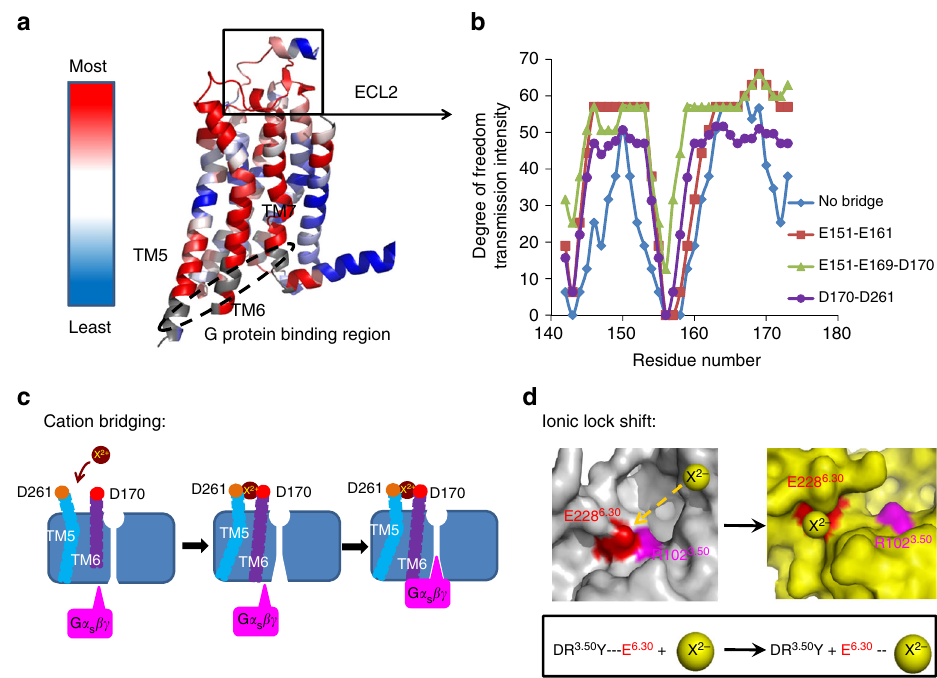
Fig. 7 Proposed mechanism of allosteric activation of A 2A R by divalent cations. a Using the RTA analysis, regions are colored based on the intensity of degrees of freedom (DOF) transmitted to the G-protein-binding region (depicted in a dashed ellipse) with red regions having highest transmission. b Comparison of intensity of transmission of degrees of freedom to the G-protein-binding site as a result of perturbing rigidity through rigidi fi cation of sliding windows of three consecutive windows in the region corresponding to ECL2, with and without cation bridges ascertained by MD simulations. c Cartoon representation for divalent cation bridge of D261-D170 affecting A 2A R activation. d Potential mechanism of disruption of the ionic lock by divalent